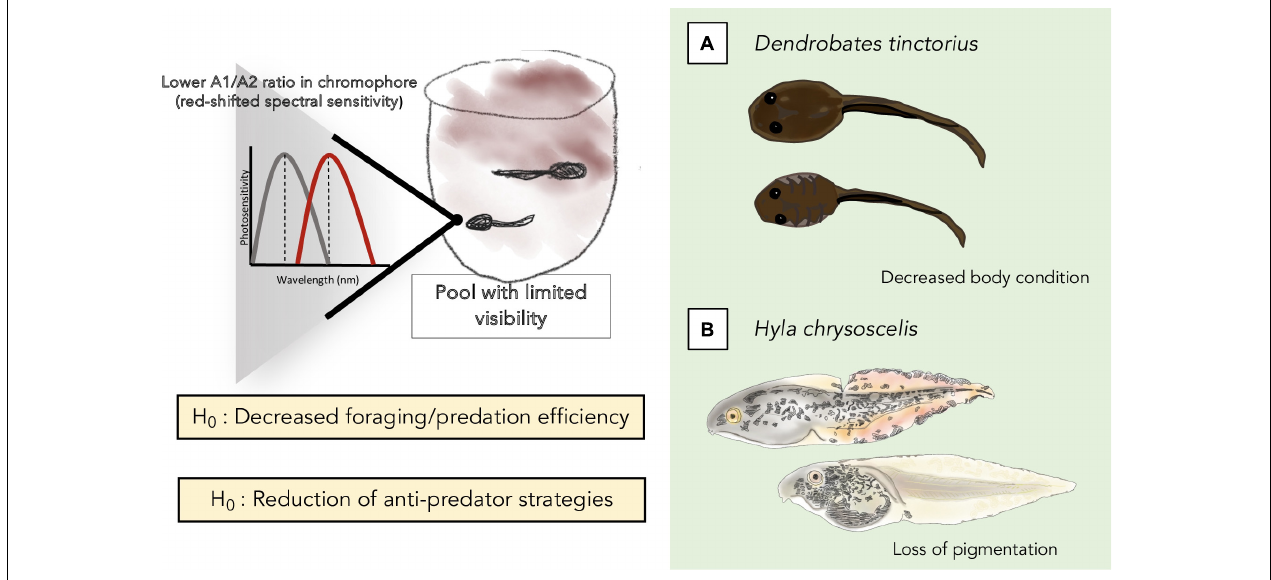
FIGURE 2 | Summary of the potential effects of turbidity on tadpoles that we hypothesize and elaborate on in the text, at the biochemical/phototransduction level (top left), and on foraging/predation (A) and anti-predation (B) strategies and